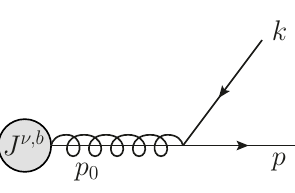
Figure 1 . Feynman diagrams for the two splitting processes involving massive quarks Q ! Qg (left) and g ! Q (cid:22) Q (right). The o(cid:11)-diagonal splitting process Q ! gQ can be obtained from the result for Q ! Qg via crossing. J and J (cid:23);b represents the remaining amplitude that produces the incident highly energetic parent quark or gluon